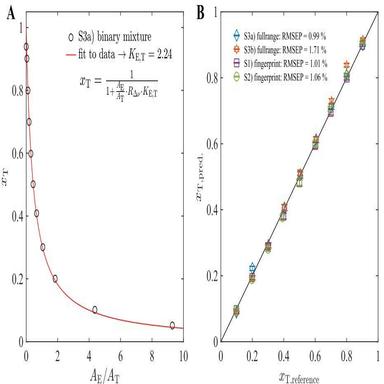
A) Determination of the fundamental calibration constant KE,T = 2.24 ± 0.08 (1-σ confidence bounds) derived from a fit of known reference mole fractions xT with respect to the estimated Raman area ratio AE/AT; The RMSEP and predicted mole fractions xT,pred of independent measurements with setups S1 – S3 are depicted in B; on average an RMSEP of 1.19% could be achieved.